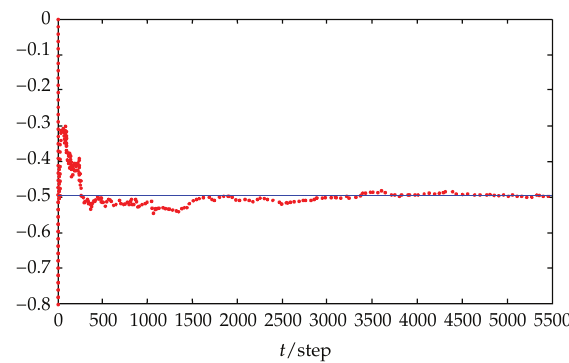
Figure 6: ρ 2 and the convergence of estimation value (cid:11) ρ 2 (cid:5) t (cid:6)